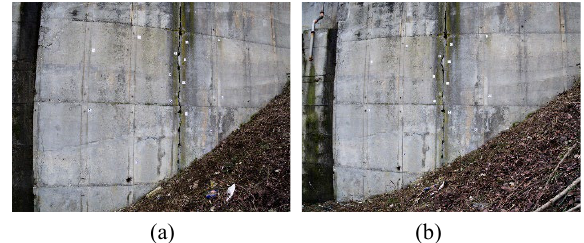
Figure 10 . Stereo-pair of images used in the test: (a) image A (left-hand side); (b) image B (right-hand side). The two images are not undistorted yet.